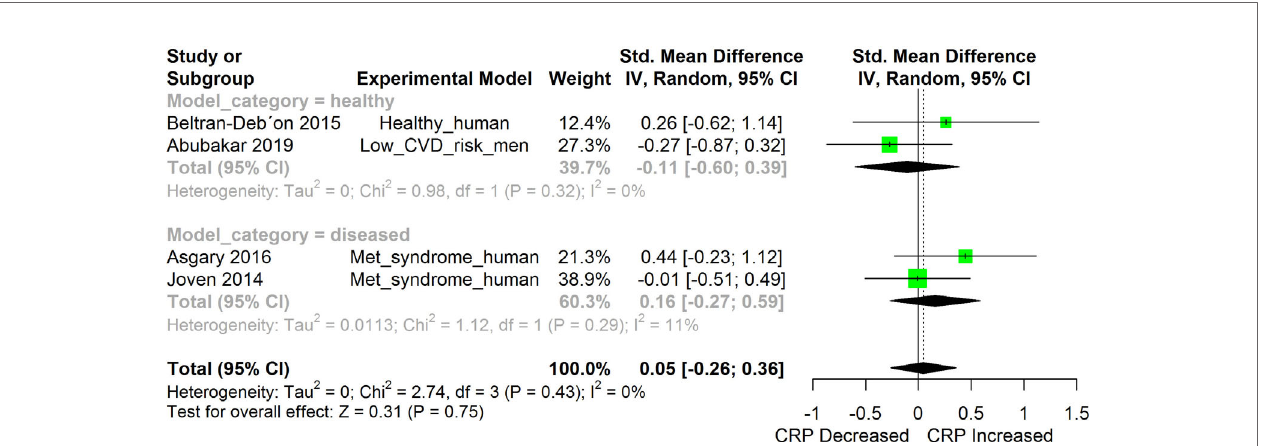
FIGURE 9 | Meta-analysis and forest plot of the effect of HS administration on CRP. The meta-analysis was sub-grouped by health status (i.e diseased or healthy state). The standardized mean difference (SMD), which is an estimate of the effect size, is presented as a square on the forest plot, for each study and as a diamond for the pooled estimate of each subgroup or overall studies. The overall pooled SMD for all included studies is shown in the bottom section of the forest plot. SMD data points that are lower than zero signify that treatments with HS lowered the level of the biomarker while those greater than zero signify that HS treatment causes an increase in the levels of the biomarker. The statistical signi fi cance of the pooled estimate is indicated by the Z test of signi fi cance. Met, Metabolic.